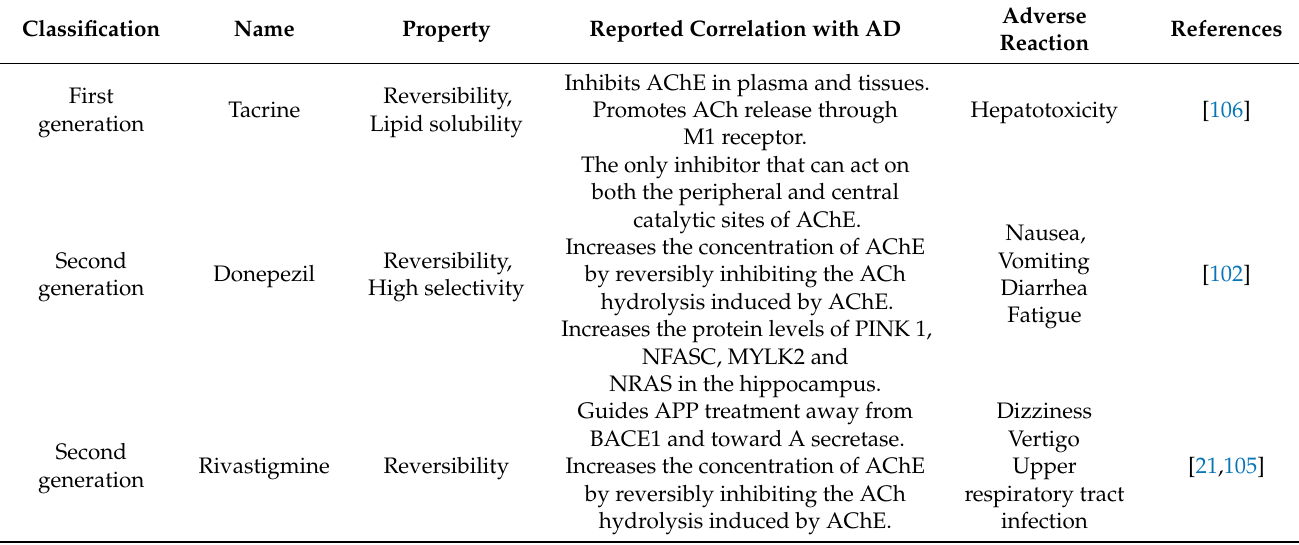
Figure 3. Some drugs related with the treatment of AD. Table 1. Summary the AChEI drugs approved by